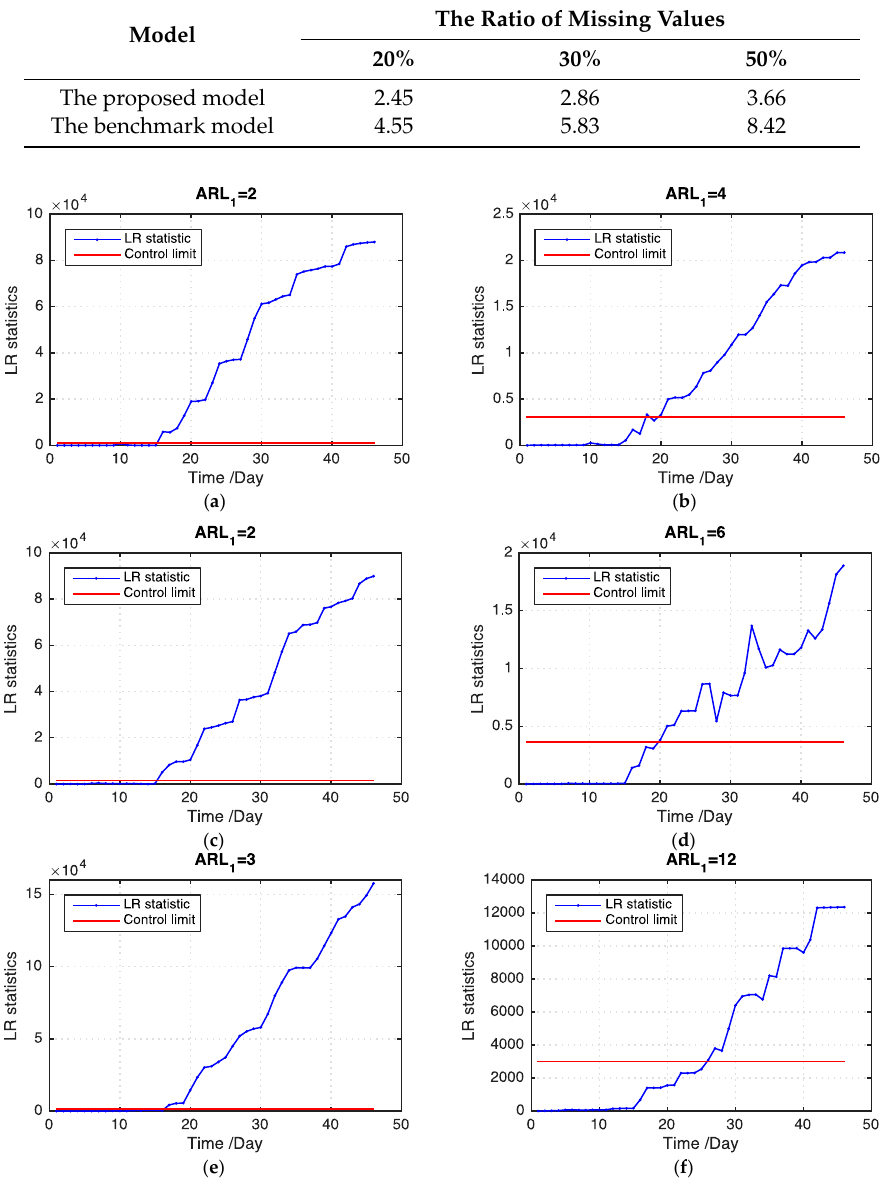
Figure 8. LR statistics using the proposed model and benchmark model for the real case. ( a ) The proposed model includes 20% missing values; ( b ) The benchmark model includes 30% missing values; ( c ) The proposed model includes 30% missing values; ( d ) The benchmark model includes 30% missing values; ( e ) The proposed model includes 50% missing values; ( f ) The benchmark model includes 50% missing values.